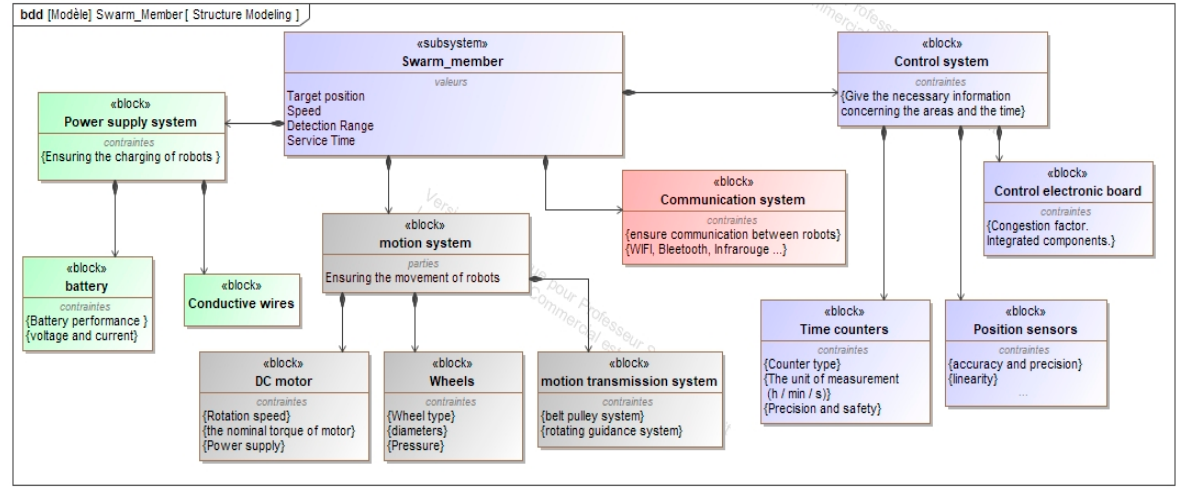
Figure 6. The swarm member structure modeled with the SysML BDD diagram.